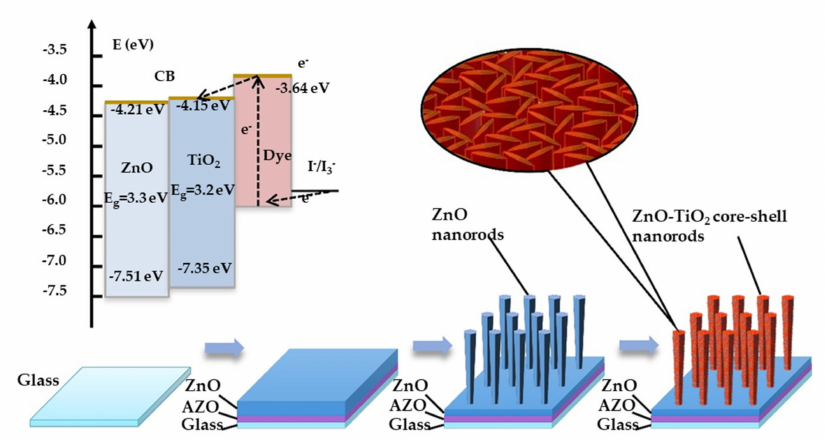
Figure 1. Fabrication mechanism and working principle of the zinc oxide–titanium dioxide (ZnO–TiO 2 ) core–shell